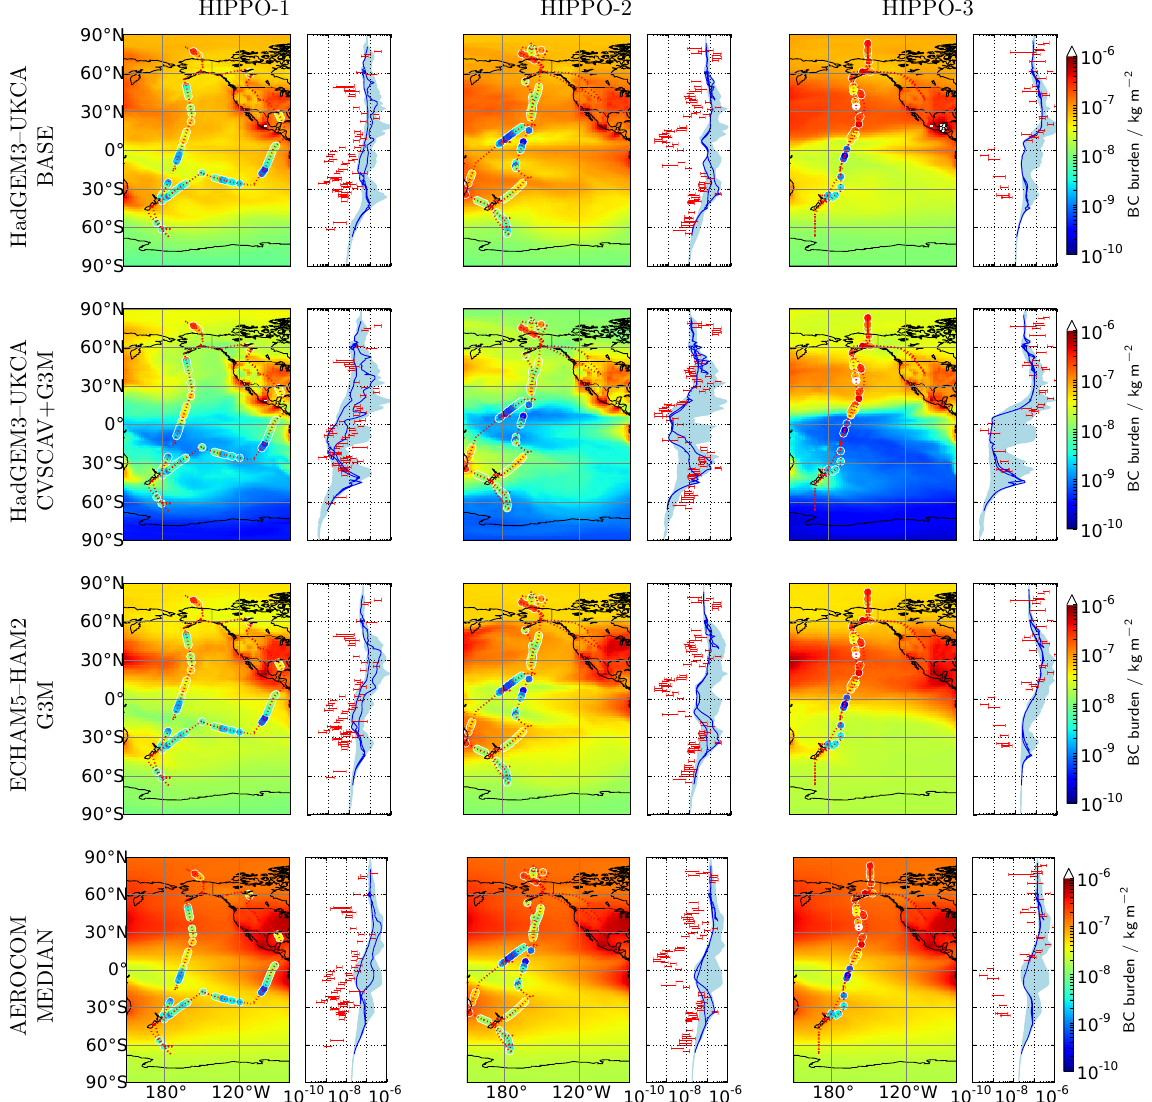
Fig. 1. Flight tracks for the first three phases of the HIPPO campaign (January 2009, October/November 2009 and March/April 2010, respectively). The circles show the BC burden (in kgm − 2 ) estimated from the HIPPO SP2 observations over each vertical profile, while the background shading shows the monthly-mean BC burden from the HadGEM3–UKCA (BASE and CVSCAV+G3M) and ECHAM5–HAM2 (G3M) simulations. The bottom row shows the burdens from the AEROCOM Phase I (Textor et al., 2006) median model (constructed from the ARQM, GISS, GOCART, GRANTOUR, KYU, LOA, MATCH, MPI HAM, MOZGN, PNNL, UIO CTM, UIO GCM, ULAQ and UMI models). The side plots show the observed burdens (red bars, representing the range due to uncertainty in extrapolation of profiles to the surface and a 15km lid, plus the 30% uncertainty in the mixing ratios used), the along-track model burden (blue line, two-valued due to the southbound and northbound legs) and the zonal range of the model burden between the map edges